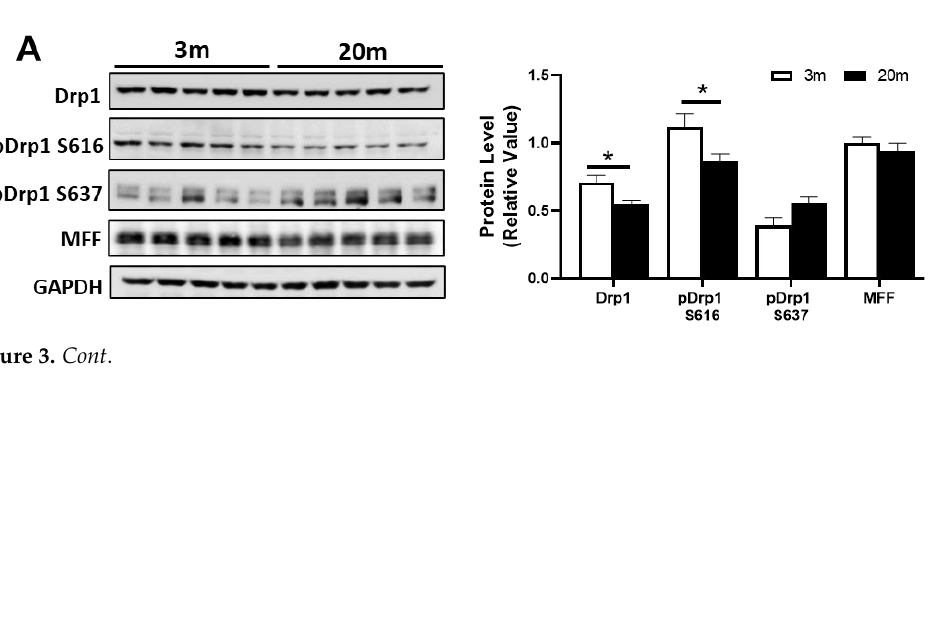
Figure 4. Changes in proteins implicated in mitochondrial fission and fusion processes in the hippocampus of aged female C57BL/6J mice. ( A ) Western blot of hippocampal lysates of 3 mo and 20 mo old mice, with their densitometric analysis of proteins involved in mitochondrial fission, in- cluding Drp1, pDrp1 S616, pDrp1 S637, and mitochondrial fission factor (MFF). ( B ) Western Blot of the protein involved in mitochondrial fusion, including Mfn1, Mfn2, and OPA1. ( C ) Representative TEM images and analysis showing mitochondrial length and mitochondrial AR in both 3 mo and 20 mo mice (26,500×). The scale bar corresponds to 500 nm. Densitometric analysis is expressed as levels relative to control. Graph bars represent means ± SEM. * p < 0.05, *** p < 0.005, **** p < 0.001. 2.5. Reduced Mitochondrial Mass in the Aged Hippocampus, with Decreased Mitochondrial Biogenesis and Mitophagy Other important processes that contribute to the proper functioning of mitochondria as a mechanism of quality control are mitochondrial biogenesis, which generates new mi- tochondria, and mitophagy, which eliminates damaged mitochondria [53]. Several reports show that the deregulation of these processes in the hippocampus occurs in neurodegen- erative disease [54–56], with controversial results in aging [55]. Regarding mitochondrial biogenesis, the master regulator is PPAR-Gamma-Coactivator- 1α (PGC - 1α), which regu- lates other factors, such as Nuclear Respiratory Factors (NRF1 and NRF2) [57]. NRF1